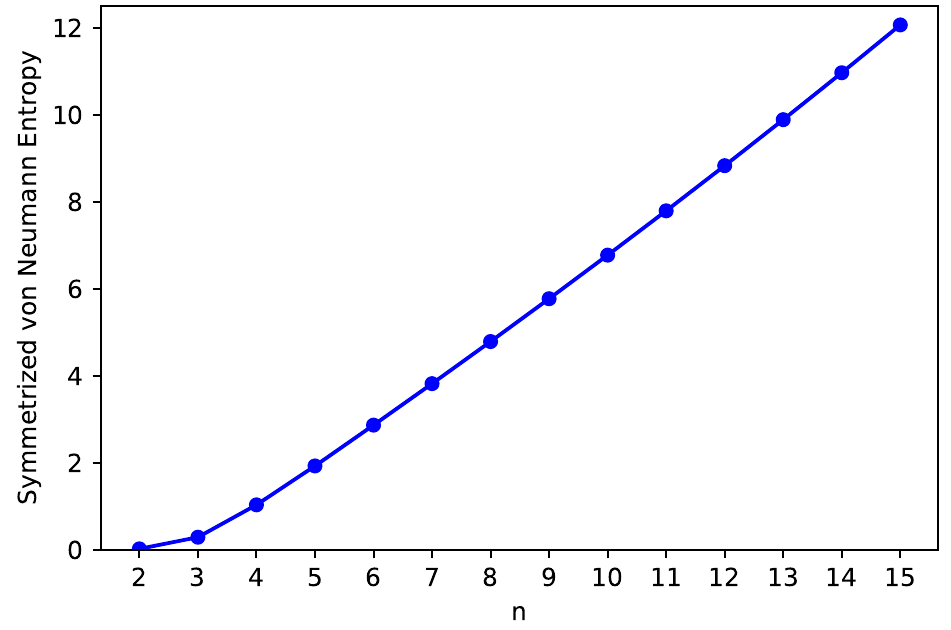
Figure 6. Symmetrized von Neumann entropy of ground-state n -pyrene, calculated by spin-unrestricted